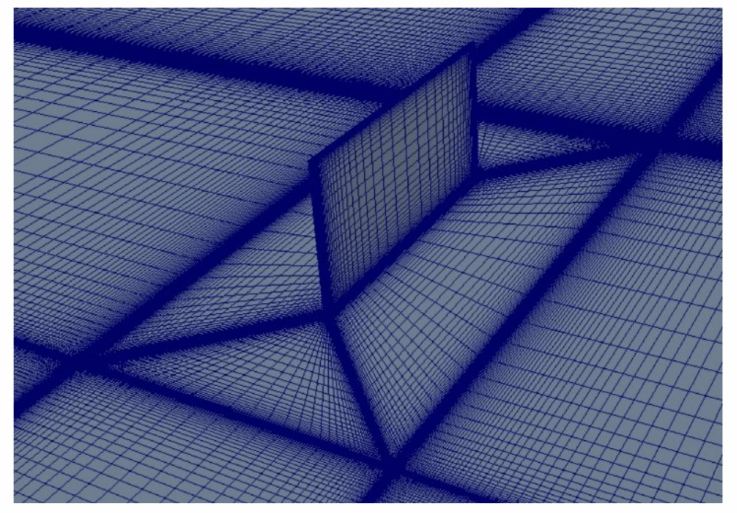
Figure 2. Refined mesh near the VG.